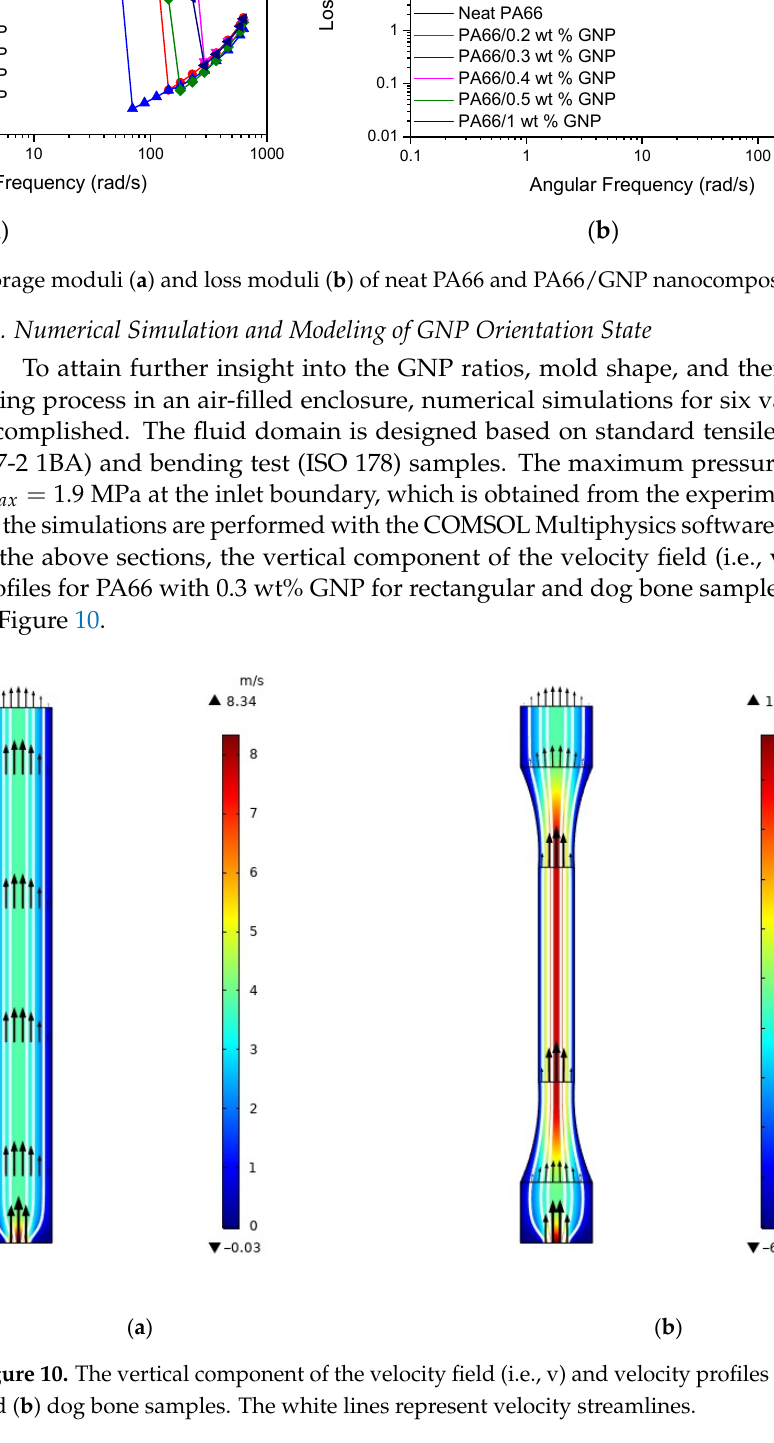
Figure 8. Complex viscosity of neat PA66 and its GNP-based nanocomposites as a function of an- gular frequency.